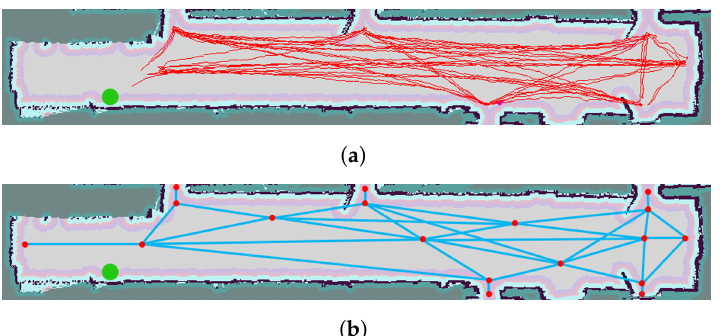
Figure 11. Trajectory patterns extracted in a corridor, taking into account possible destinations. The sensor location is indicated in green: ( a ) Trajectories sensed in the environment; and ( b ) pattern resulting from processing the